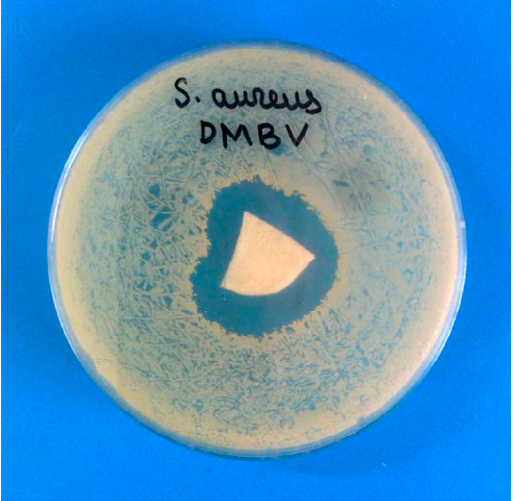
Figure 7. The result of the diffusion test, which demonstrates the formation of the zone of inhibition of the growth of bacteria Staphylococcus aureus caused by the release of vancomycin from the Ca-alginate